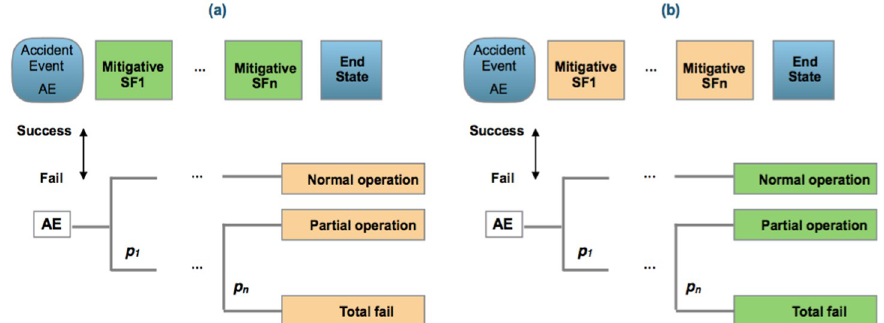
Figure 7. Analysis modes of the hidden Markov chain. ( a ) Defining transition probabilities for the mitigative barriers (highlighted green) and emission probabilities for the observed end sates in function of the mitigative barriers (highlighted brown); ( b ) defining transition probabilities for the end states (highlighted green) and emission probabilities for the observed mitigative barriers states (highlighted brown).